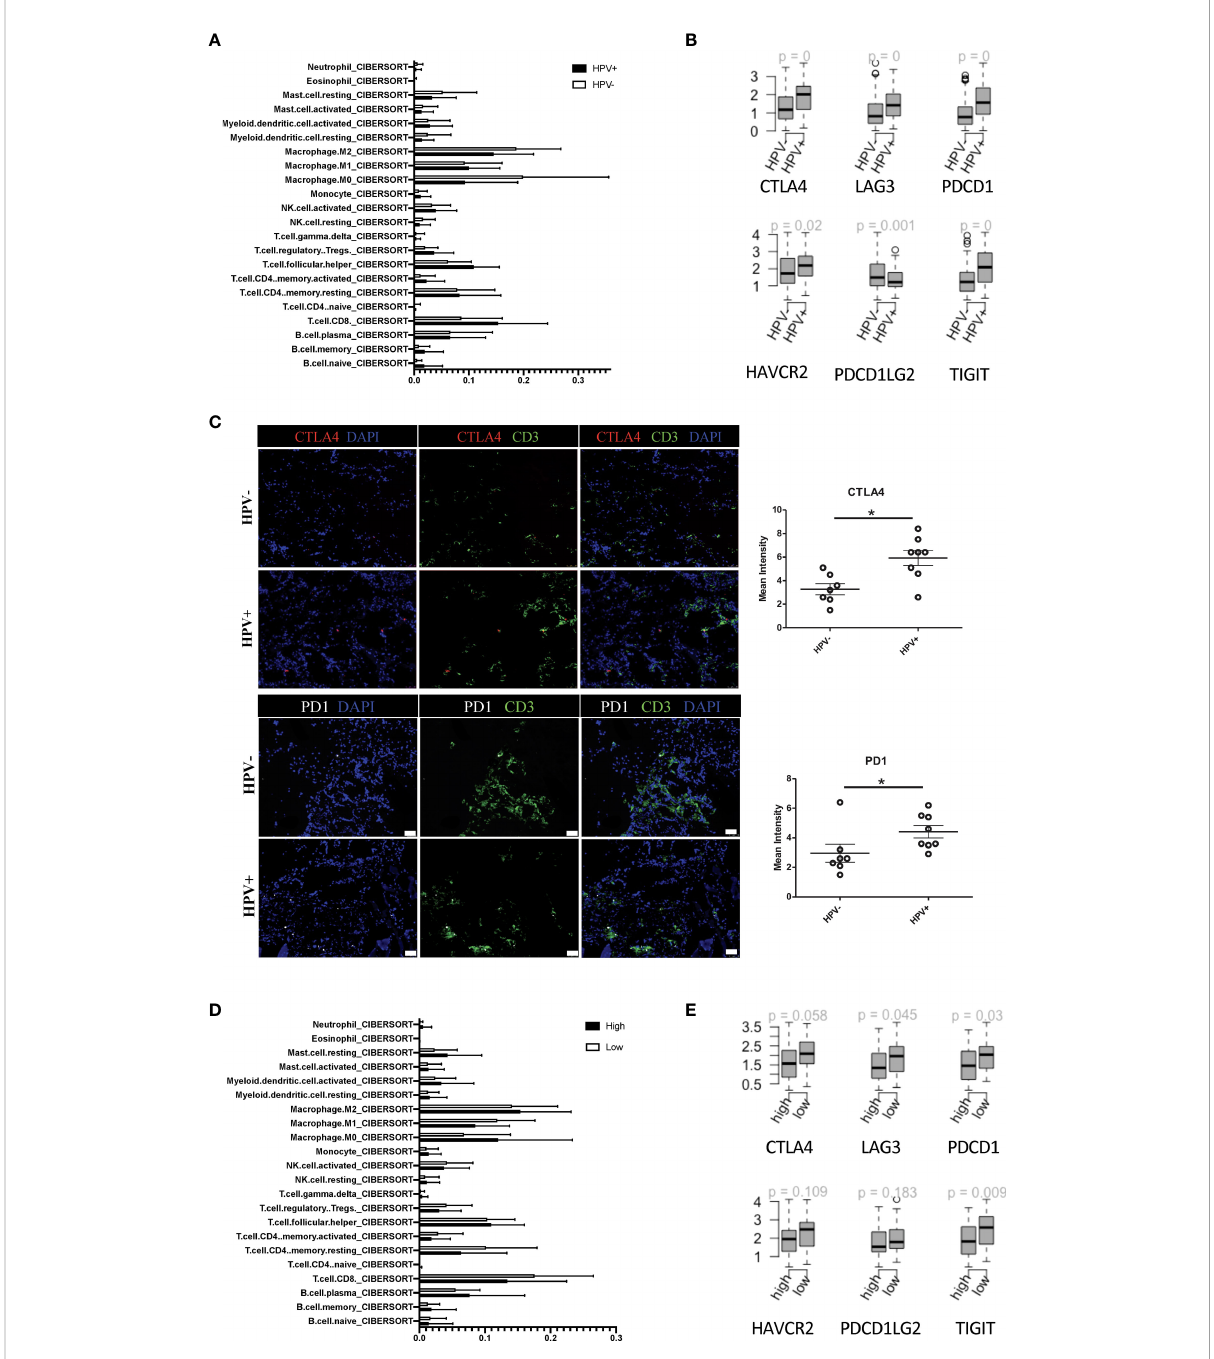
FIGURE 4 Tumour in fi ltrated immune cells in HPV + and HPV - HNSCC patients. (A) A bar graph showing the CIBERSORT estimated in fi ltration of immune cell subsets of samples from HPV + and HPV - HNSCC patients. (B) The relationship between HPV groups and immune checkpoint genes. Boxplots showing the gene expression levels of CTLA4, LAG3, PDCD1, PDCD1LG2, TIGIT and HAVCR2 in the HPV + and HPV - HNSCC patients. p=0 refers to p<0.0001. (C) Representative immuno-stained photomicrographs of CTLA4 and PD1 in surgical sections obtained from patients with HNSCC. The CD3 stain shows the tumour in fi ltrated T cells. The data are means ± SD of 7 experiments and were analysed using Student ’ s t test; *P<0.05. (D) A bar graph showing the CIBERSORT estimated in fi ltration of immune cell subsets in the high- and low-risk groups of HPV + HNSCC patients. (E) Boxplots showing the gene expression levels of CTLA4, LAG3, PDCD1, PDCD1LG2, TIGIT and HAVCR2 in the high- and low-risk groups of HPV + HNSCC